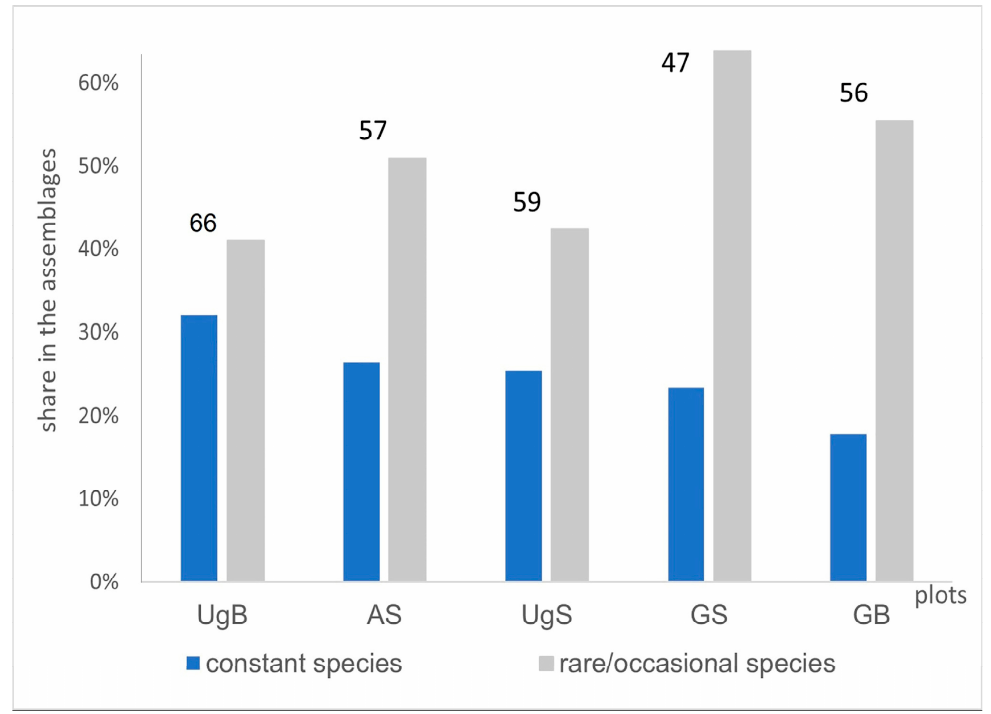
Figure 3. The constant and rare species ratio at the monitoring plots during the study period (2012–2019). The numbers above the bars indicate the total number of species in the habitat. For the abbreviations, see Table 1.